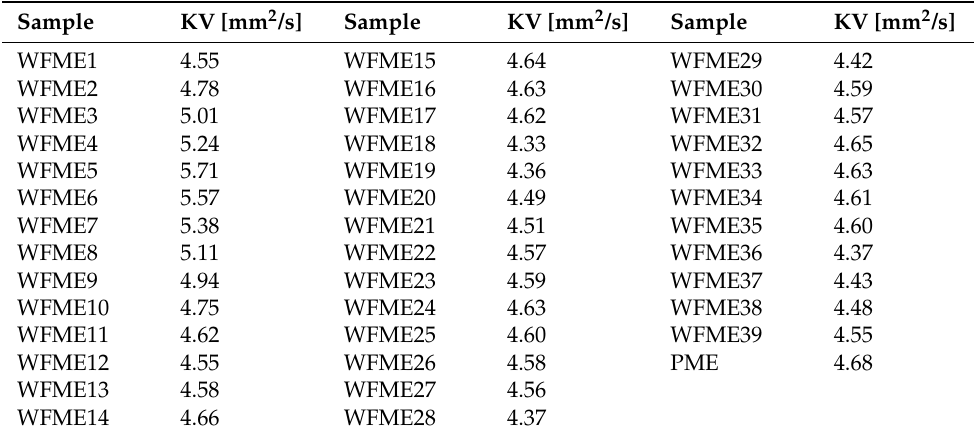
Table 3. Kinematic viscosity of all biodiesel samples at 40 ◦